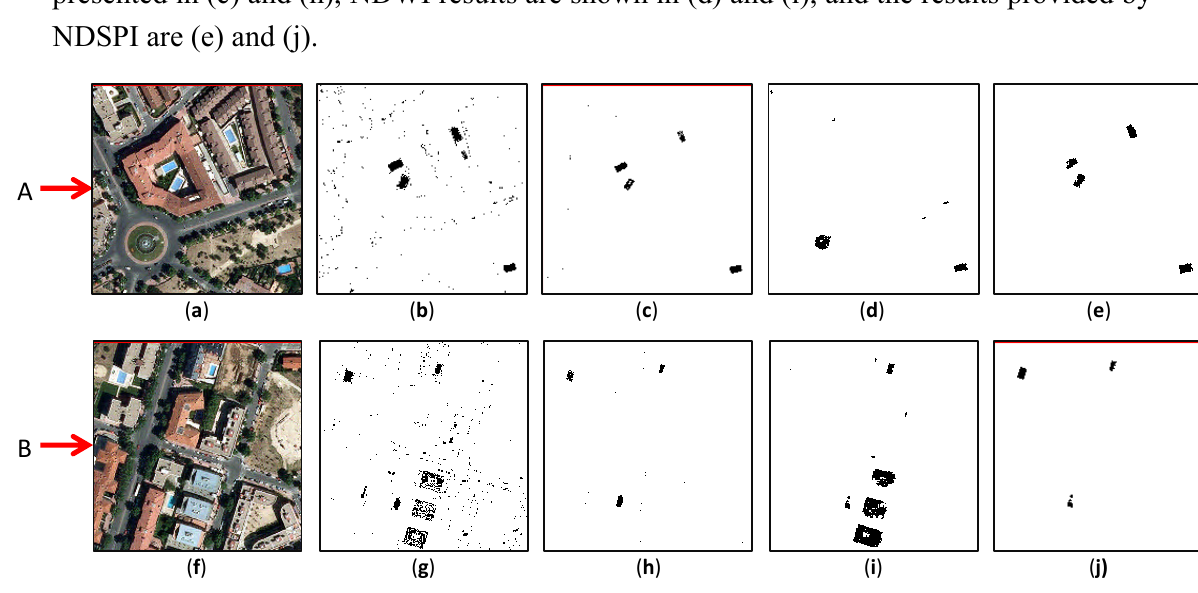
Figure 10. Results for two 200 × 200 details of the studied area are represented